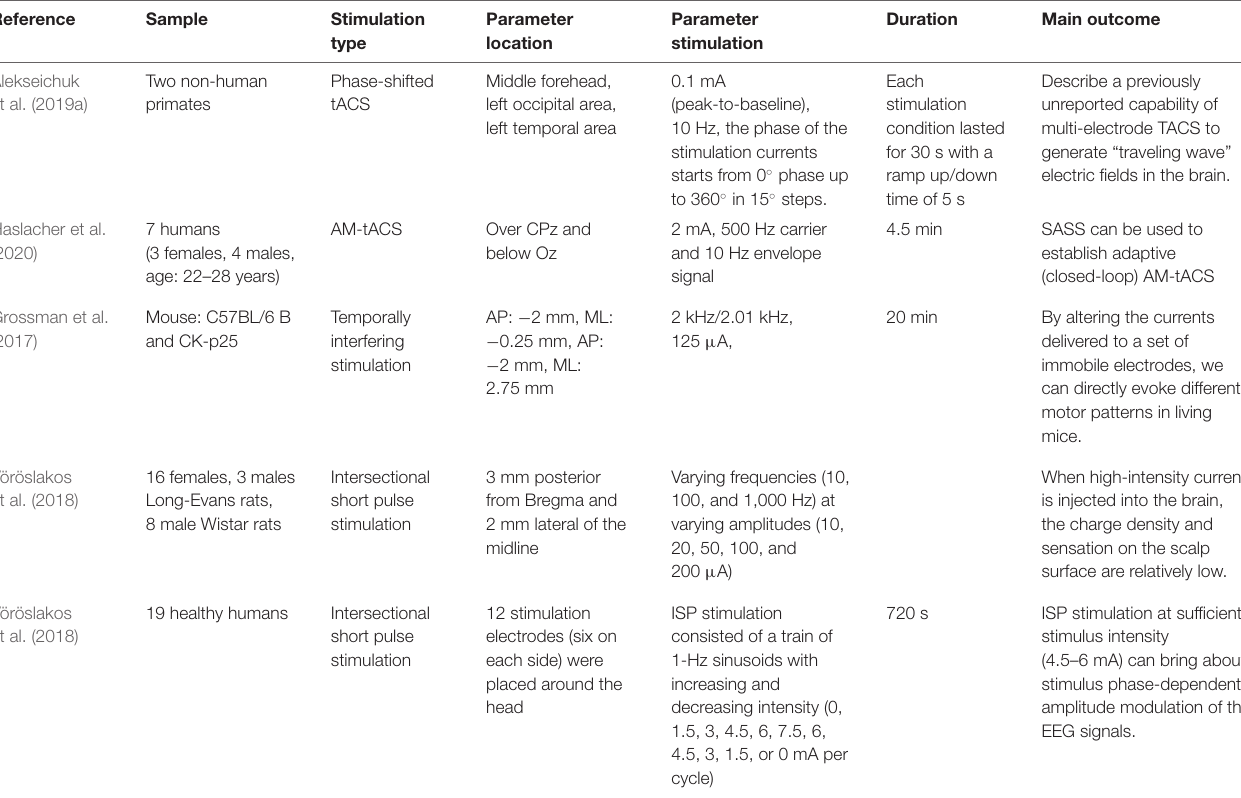
TABLE 2 | Interference modulation electrical